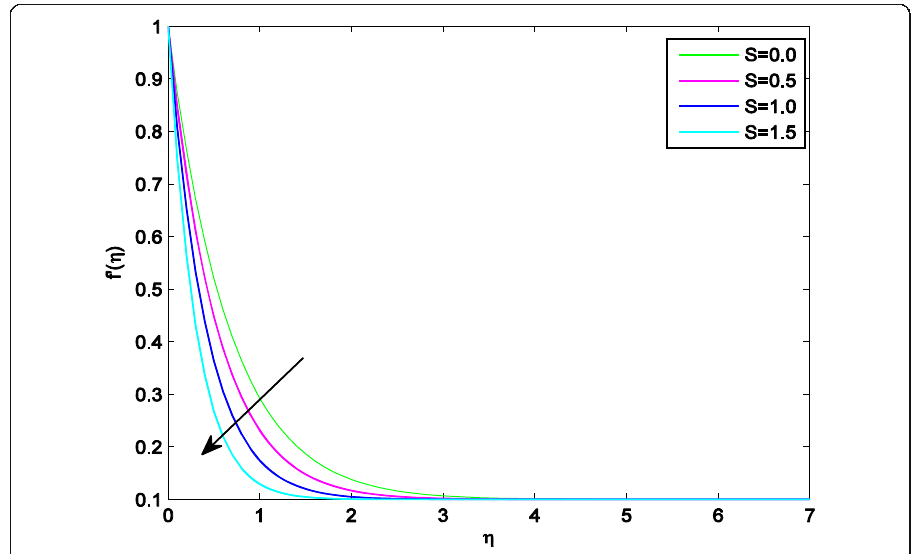
Fig. 6 Velocity graph for various values of